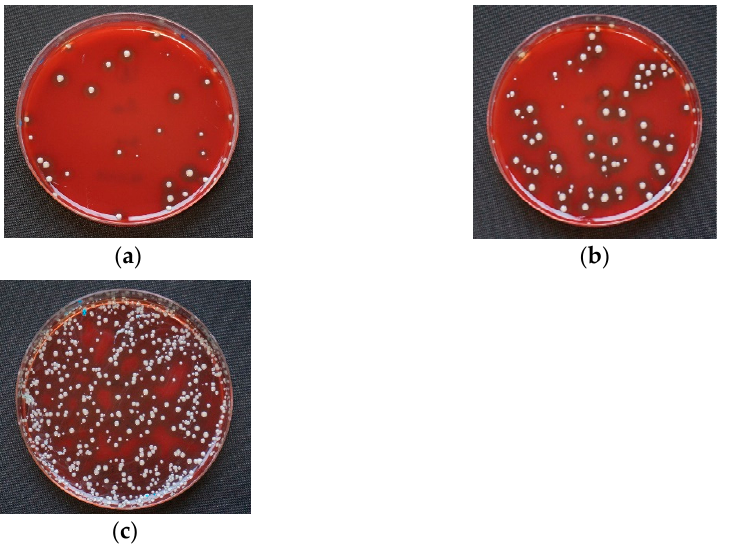
Figure 3. Examples for Staphylococcus aureus on Columbia agar at baseline after 0 min incubation. ( a ) Universal Adhesive (UA); ( b ) Polyether Adhesive (PA); ( c ) Polyether Contact Tray Adhesive (PCTA). In Fix adhesive (FA), no colonies of Staphylococcus aureus could be detected.